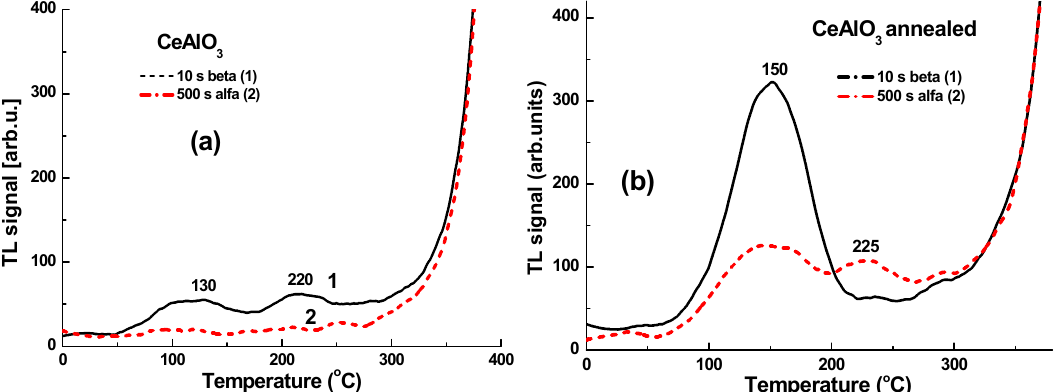
Figure 12. Thermoluminescence (TL) glow curves of as-grown ( a ) and annealed ( b ) CeAlO 3 crystals after α - and β - particle excitation with 239 Pu (1) and 90 Sr/ 90 Y (2) sources.